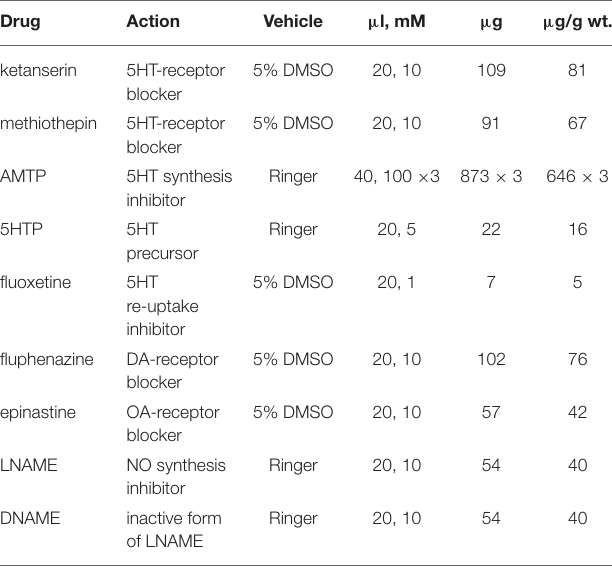
TABLE 1 | Drugs, actions, and effective dosages without detrimental effects on motility. Drug